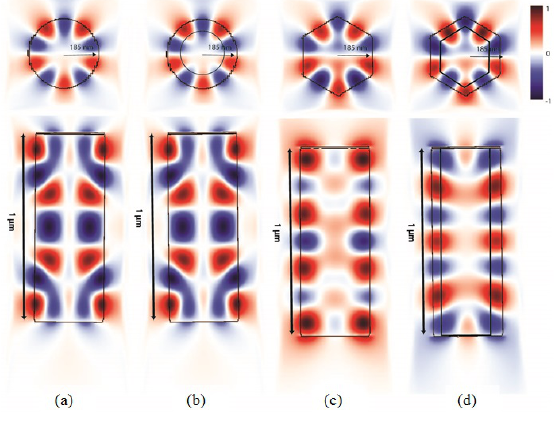
Figure 5: Cavity modes for (a) core-only cylindrical, (b) core–shell cylindrical, (c) hexagonal core-only, and (d) hexagonal core–shell. The radius of nanowire is 185 nm and the height is 1 µ